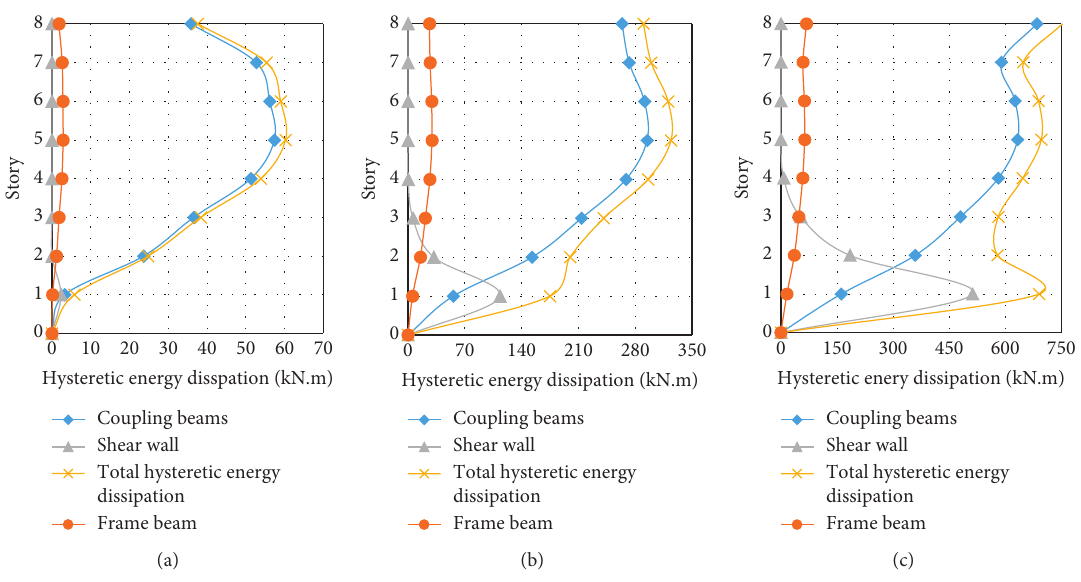
Figure 10: The hysteretic energy dissipation of structure A. (a) PGA � 0.2 g. (b) PGA � 0.4 g. (c) PGA �